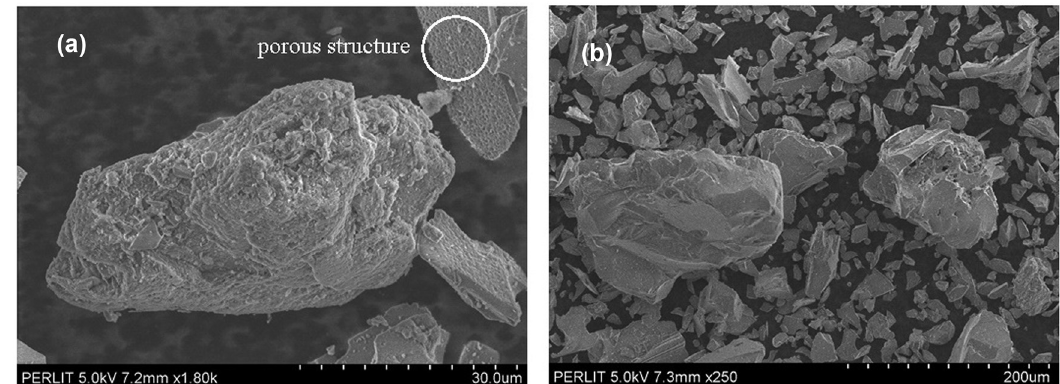
Figure 1: SEM image of the perlite micro/nano - fi